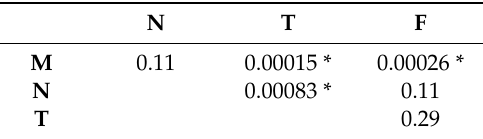
Figure 2. Participants’ scores for di ff erent selection confirmation methods ( N = 23, M ± 95% CI): M—confirmation by pressing the left mouse button, N—confirmation by pronouncing the circle number, T—confirmation by pronouncing the word “ty” (“you” in Russian), F—confirmation by pronouncing the word chosen by the participant himself. Table 1. p -values obtained in a post-hock Tukey test for individual convenience scores given to di ff erent selection confirmation methods (* p < 0.05). See the caption of Figure 1 for the description of the confirmation methods.